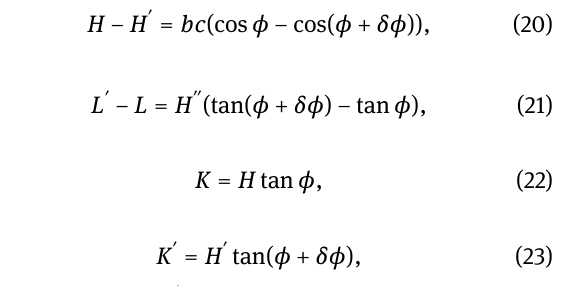
Figure 9. Reducing L will increase stiffness. Also, as angle ϕ increases due to loading the circumference of the foot of the band must increase. This will increase the resistance to deformation.